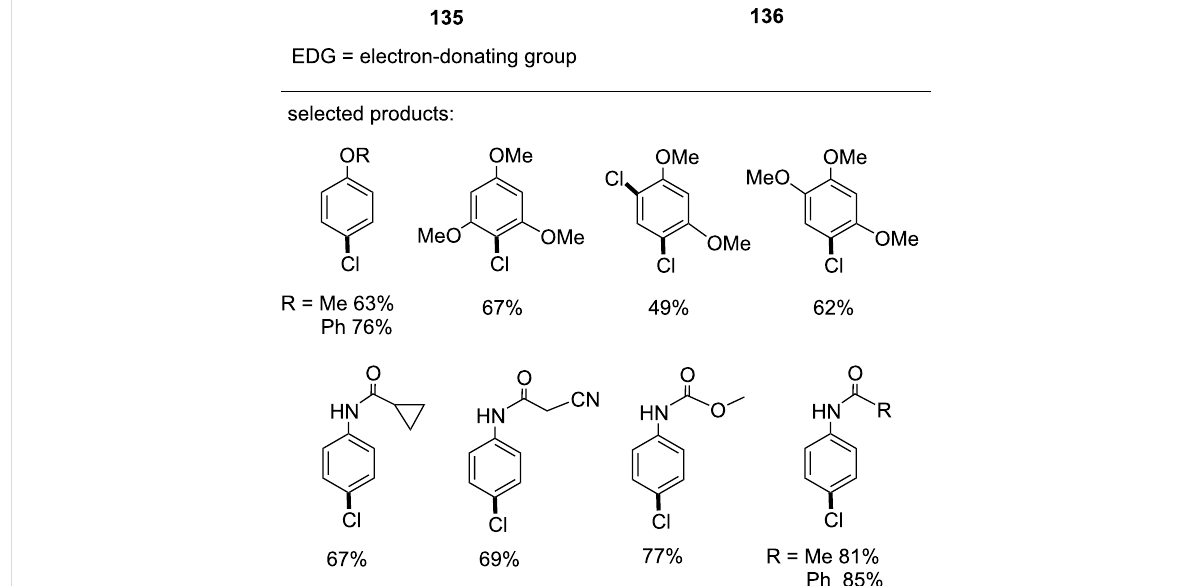
Scheme 23: Chlorination of arenes with 4CzIPN ( 5a ).